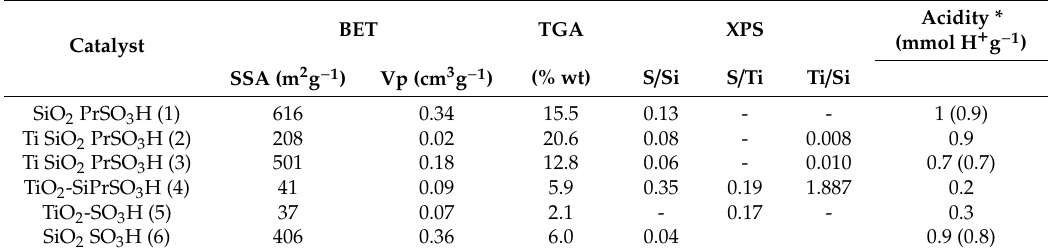
Table 1. Textural properties, XPS atomic ratio and acid capacity of the prepared materials.